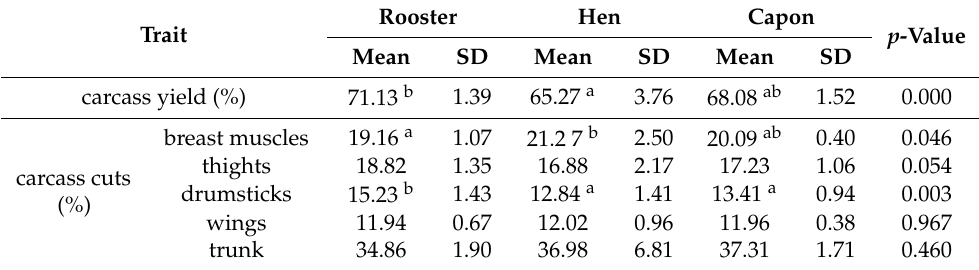
a,b means within row differ significantly at p ≤ 0.05 (Tukey